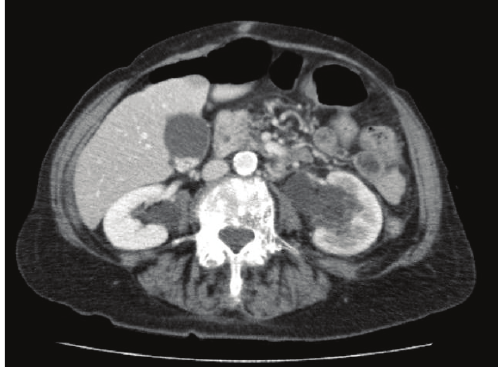
Figure2:AbdominalandPelvicCTshowingbilateralhydronephro-